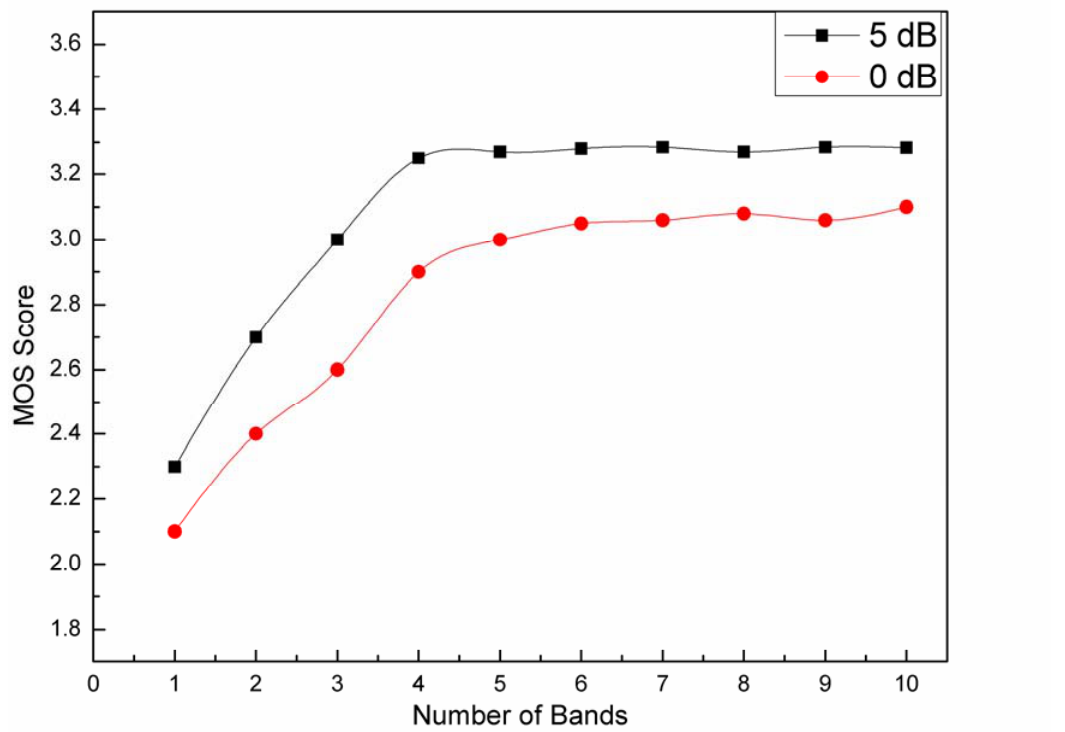
Figure 6 . Acceptability scores of the performance of the multi-band spectral subtraction approach for different number of bands for the enhanced speech. The noisy speech in the case of additive White noise has an input SNR of 5 and 0